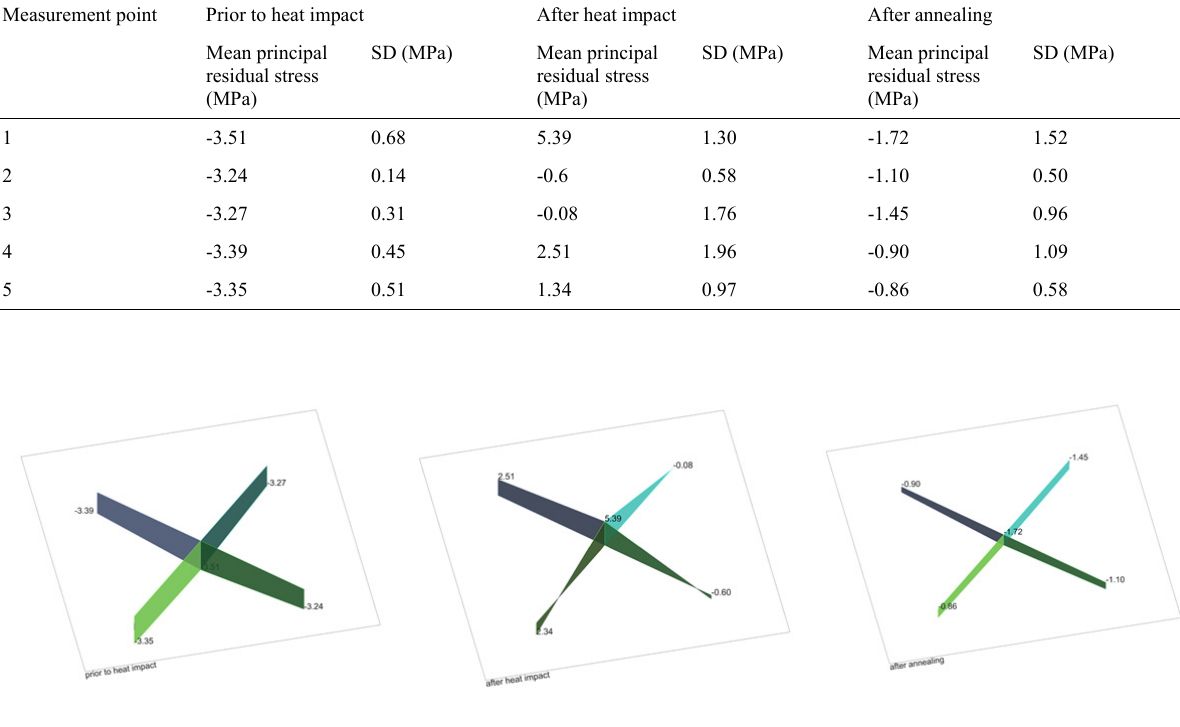
Fig. 12 principle residual stress on specimen prior to welding, after welding at 24° C and after annealing at 20°